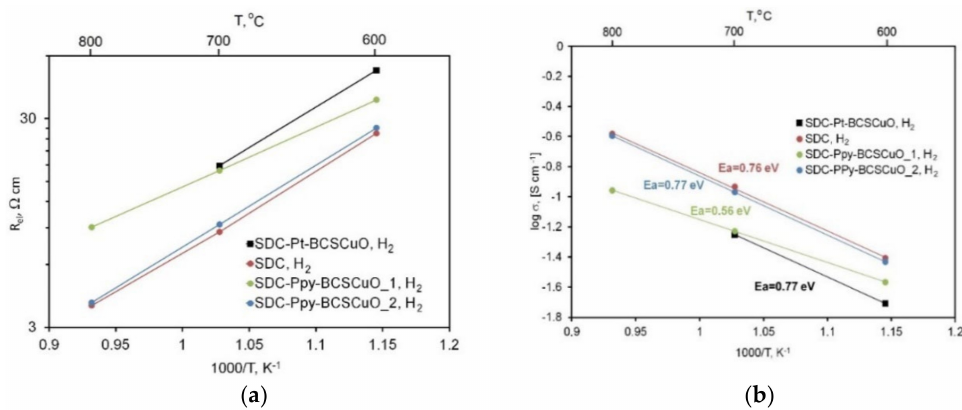
Figure 11. Electrical properties of the SDC samples without/with BCSCuO barrier layers, mea- sured under OCV conditions: ( a ) Specific ohmic resistance of the samples derived from the spectra; ( b ) Calculated values of the electrolyte substrate conductivity under the pO 2 gradient (wet air/wet hydrogen) and activation